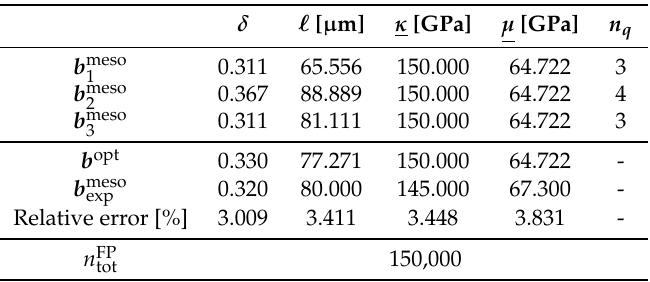
Table 6. Fixed-point iterative algorithm: comparison between the global optimal value b opt obtained from the 3 identified values b meso experimental value b meso exp